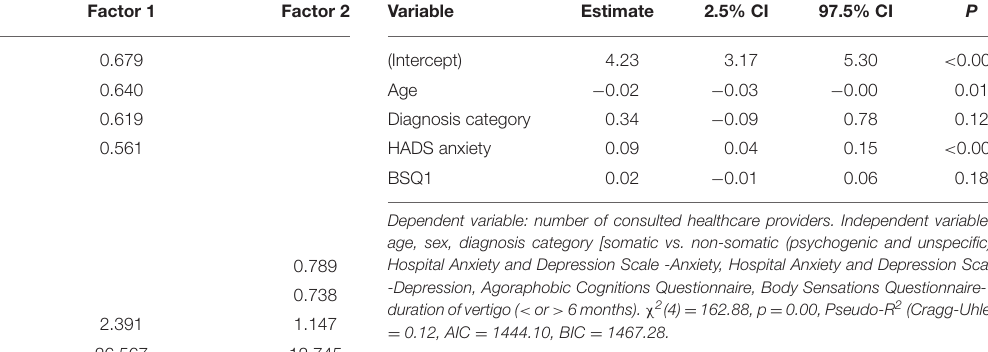
TABLE 4 | Linear regression: predictors of consulted healthcare